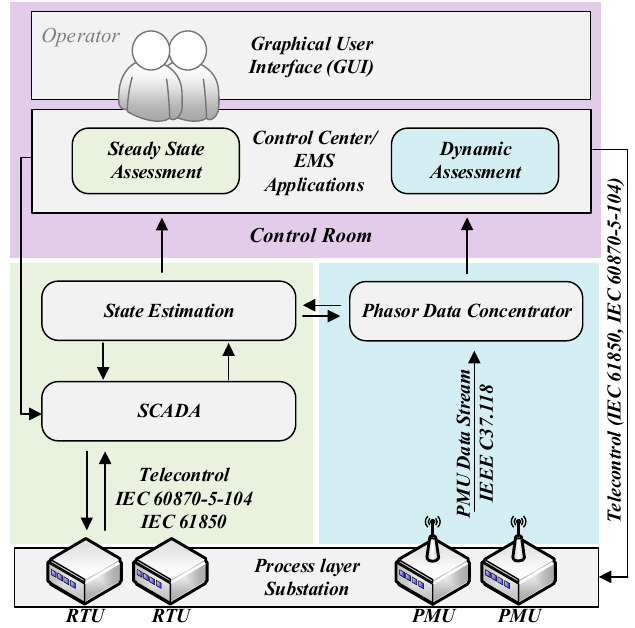
Figure 1. Simplified scheme of a modern control center.